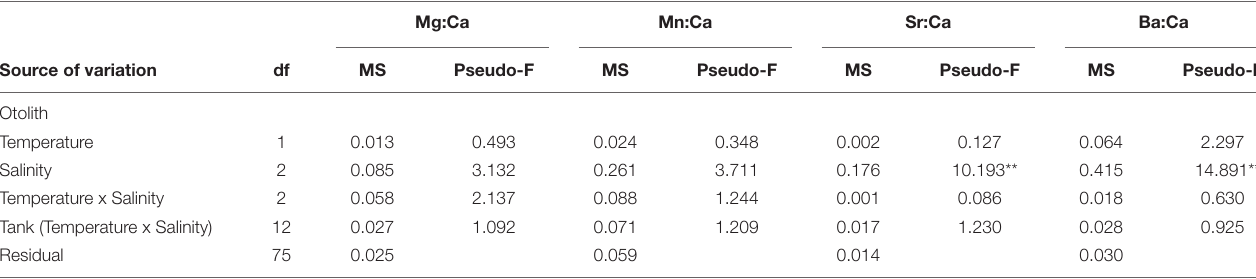
TABLE 4 | Results of the permutational analysis of variance (PERMANOVA) investigating the effects of salinity and temperature on log transformed Mg:Ca Otolith , Mn:Ca Otolith , Sr:Ca Otolith and Ba:Ca Otolith of juvenile Solea senegalensis otoliths.